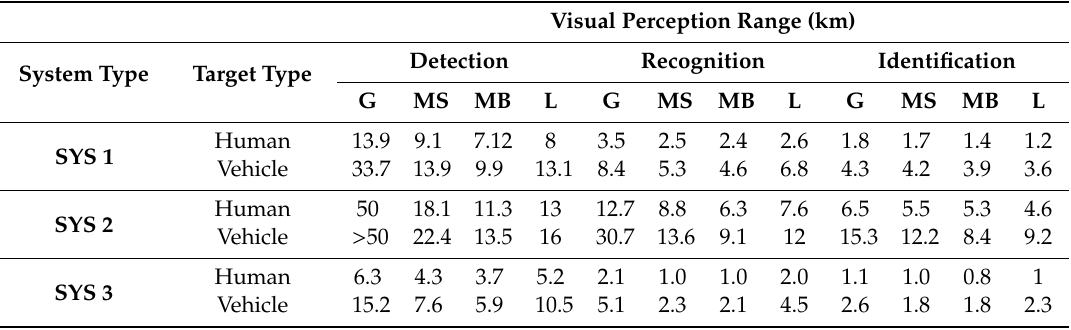
Table 7. Thermal imager range prediction measurements for selected surveillance systems.